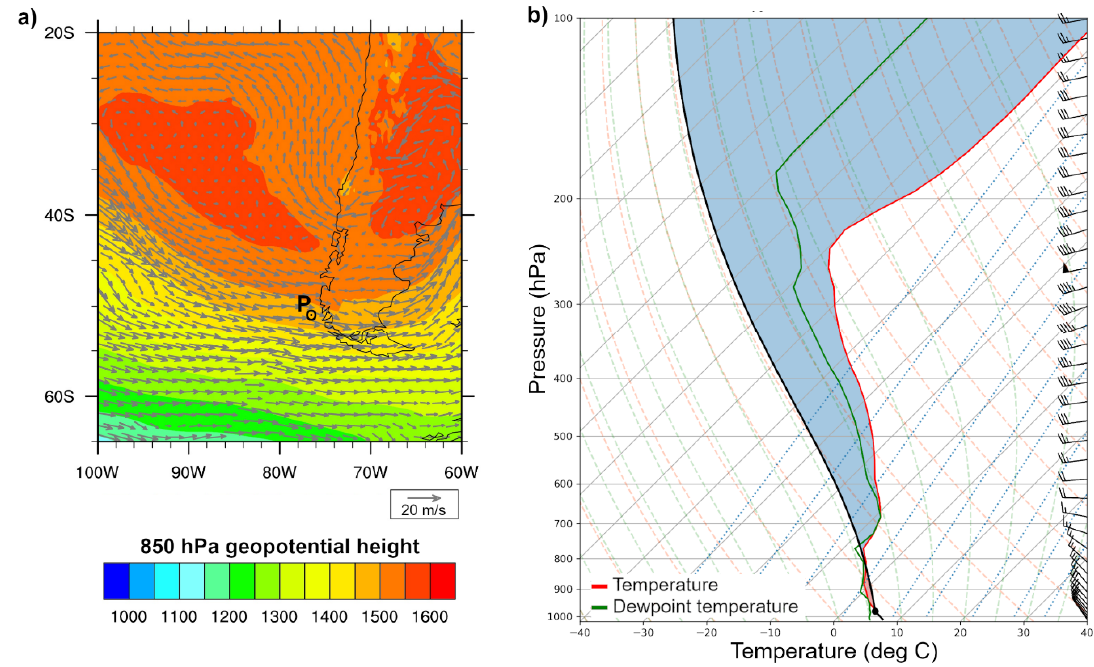
Figure 10. ( a ) Synoptic situation of 850 hPa geopotential height (color scheme) and wind vectors (arrows) derived from ERA5 and ( b ) skew-T diagram of upstream conditions, derived from WRF, at the location indicated by “P” in panel ( a ) for the subcritical case. Wind directions and speeds (one barb marks 10 m/s) are given on the right border.